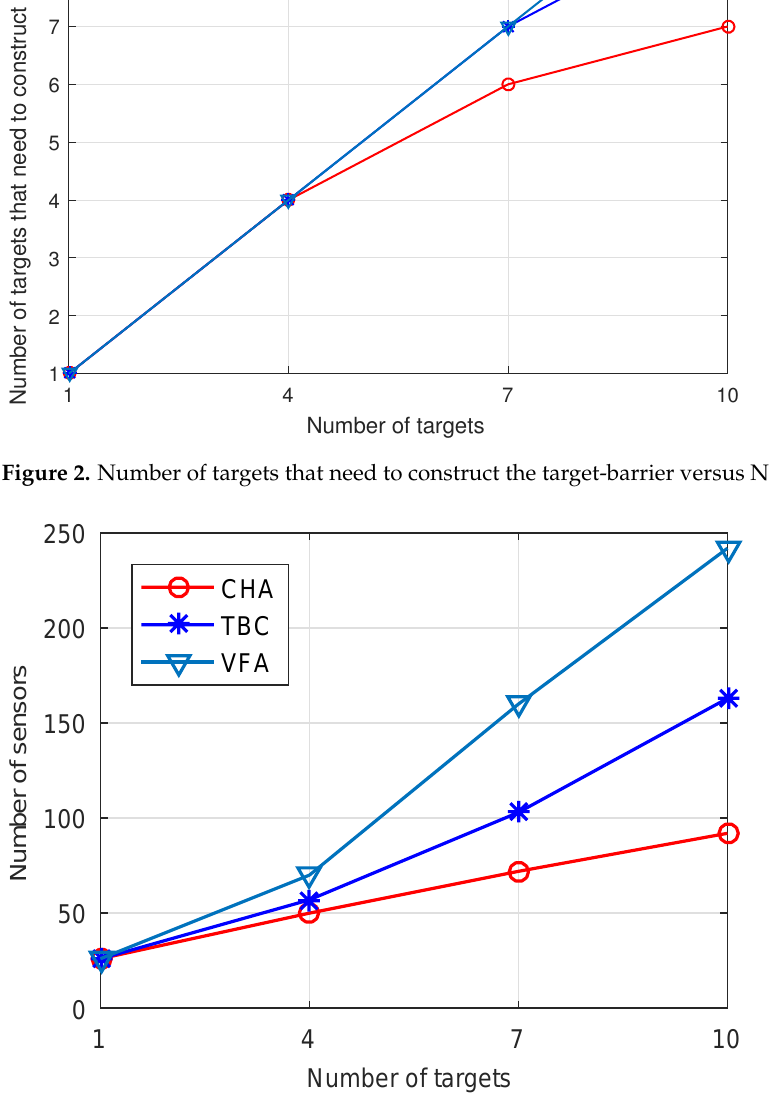
Figure 3. Numbers of sensors versus Number of